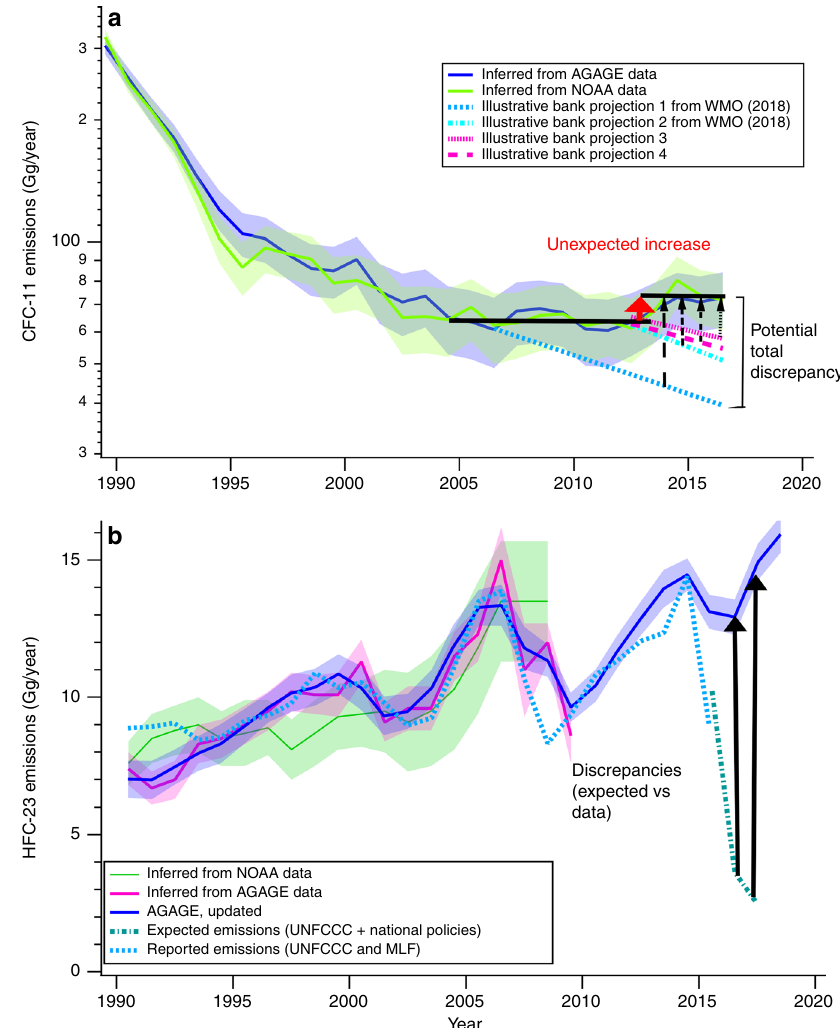
Fig. 1 Emissions of CFC-11 and HFC-23 since 1990. a CFC-11 emissions with estimated 1 σ error bars inferred from two different global data sets (set 1 (blue line) is from the AGAGE network, whereas set 2 (green) is from the NOAA network). Also shown are illustrative projections of emissions assuming no production outside of the Montreal Protocol and using different assumptions about bank sizes and release rates (blue and cyan lines from ref. 21 , which assumes about 4.3 – 4.9% bank release rates/year, whereas pink lines include larger banks within the range of ref. 8 , adopting 3 – 3.5%/year). Black horizontal lines depict averaged values for the data for 2004 – 2013 and for 2014 – 2016 as in ref. 4 ; the red arrow highlights the unexpected increase in emissions after 2013, indicating likely extra production. Black dotted and dash-dotted lines with arrows illustrate the dependence of the total discrepancy between inferred emissions from data vs. expected values from the illustrative banks. Adapted from Figs. 1 – 4 of ref. 21 . b HFC-23 emissions with estimated 1 σ error bars inferred from two different data sets (sets 2 (pink) and 3 (blue, updated from pink in ref. 12 ) are from the AGAGE network, whereas set 1 (green) is from the NOAA network, along with emissions based on national reports to the UNFCCC and Montreal Protocol Multi-Lateral Fund (MLF) through 2015 (light blue dashed line), and emissions expected based on national reports to the UNFCCC plus national policies (teal green dash-dotted line) described in ref. 12 . Solid black lines with arrows highlight recent discrepancies between inferred emissions from data vs. expected values from international and national policies. Adapted from Figs. 2 – 7 of ref. 21 , updated using ref. 12